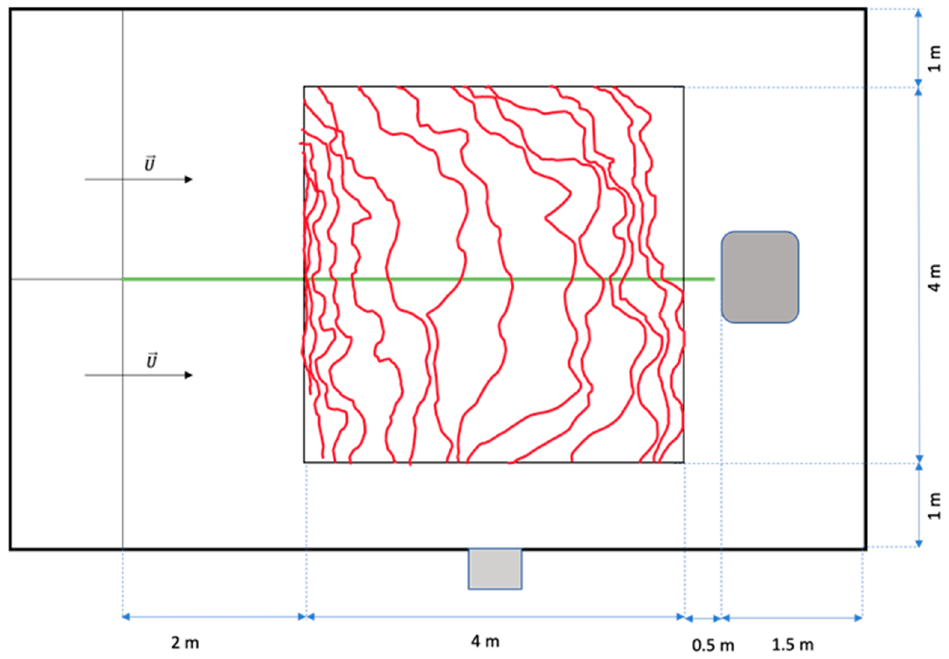
Figure 9. Fire front shape evolution for a 5 s time step—test 03 (without sidewalls).